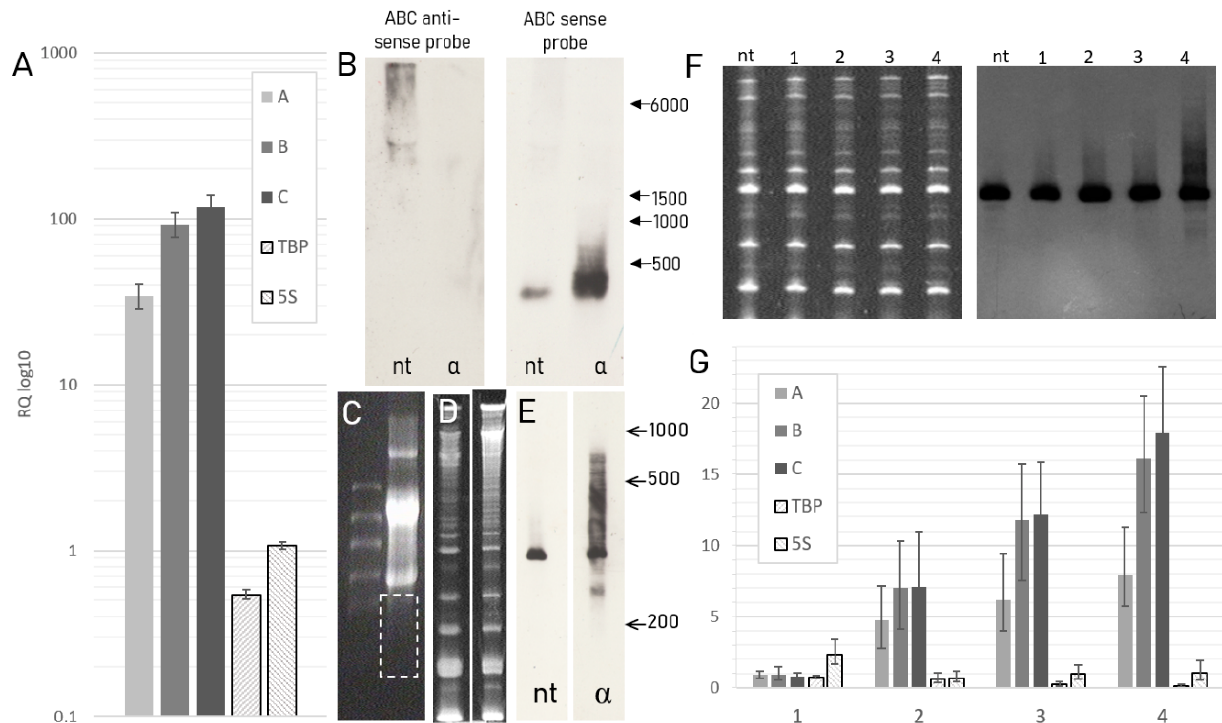
Figure 2. Gene expression analysis of alpha-amanitin treated cells versus non-treated HEK293 cells. ( A ) Relative quantity (log10) of A, B, and C regions, TBP and 5S after alpha-amanitin treatment (30 µ g/mL) normalized to 18S and to non-treated cells as reference sample ( ∆∆ C T method); ( B ) Northern blot analysis of total RNA from non-treated cells (nt) and cells treated with 30 µ g/mL alpha-amanitin ( α ) with ABC anti-sense and sense RNA probes; ( C ) Agarose gel electrophoresis of total RNA showing the area extracted for high-resolution northern blot; ( D ) PAGE-northern blot of the extracted low-molecular weight RNA fractions from non-treated (nt) and alpha-amanitin treated ( α ) cells with ABC RNA probe; ( E ) PAGE of the extracted low-molecular weight RNA fractions; ( F ) PAGE and northern blot analysis in non-treated cells (nt) and cells treated with alpha-amanitin in the following concentrations: 1.5 µ g/mL (1) 5 µ g/mL (2) 10 µ g/mL (3) 15 µ g/mL (4) with ABC RNA probe; ( G ) Relative quantity of A, B, and C regions, TBP and 5S after alpha-amanitin treatment in the above mentioned concentrations normalized to 18S and to non-treated cells as reference sample ( ∆∆ C T method).